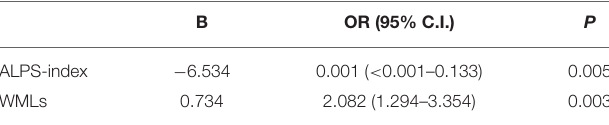
TABLE 2 | Backward stepwise logistic regression analyses for CSVD cognitive impairment. B OR (95%